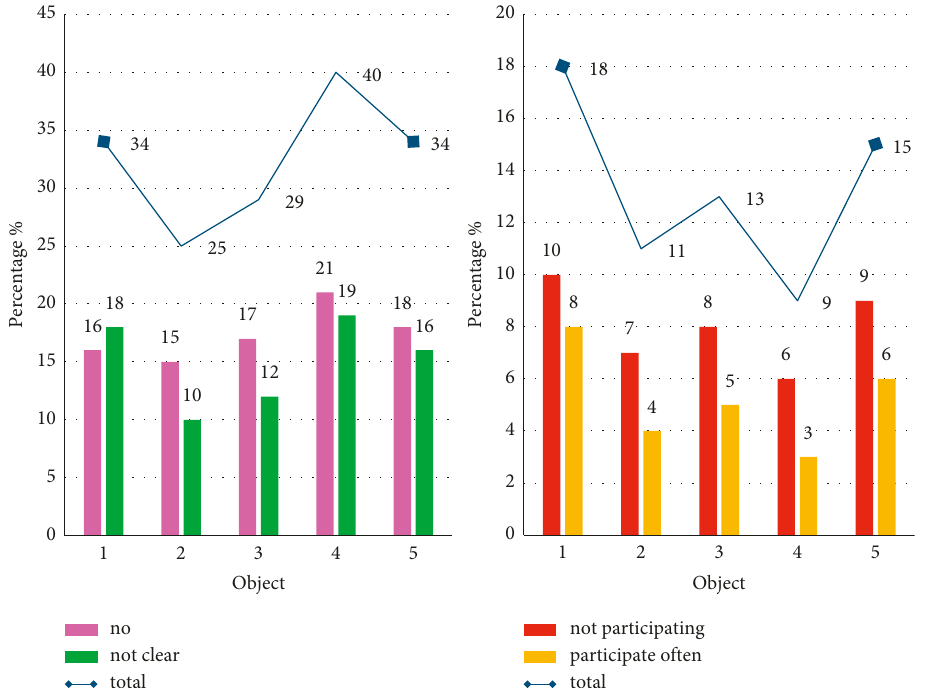
Figure 8: Percentage of participation in entrepreneurial networking